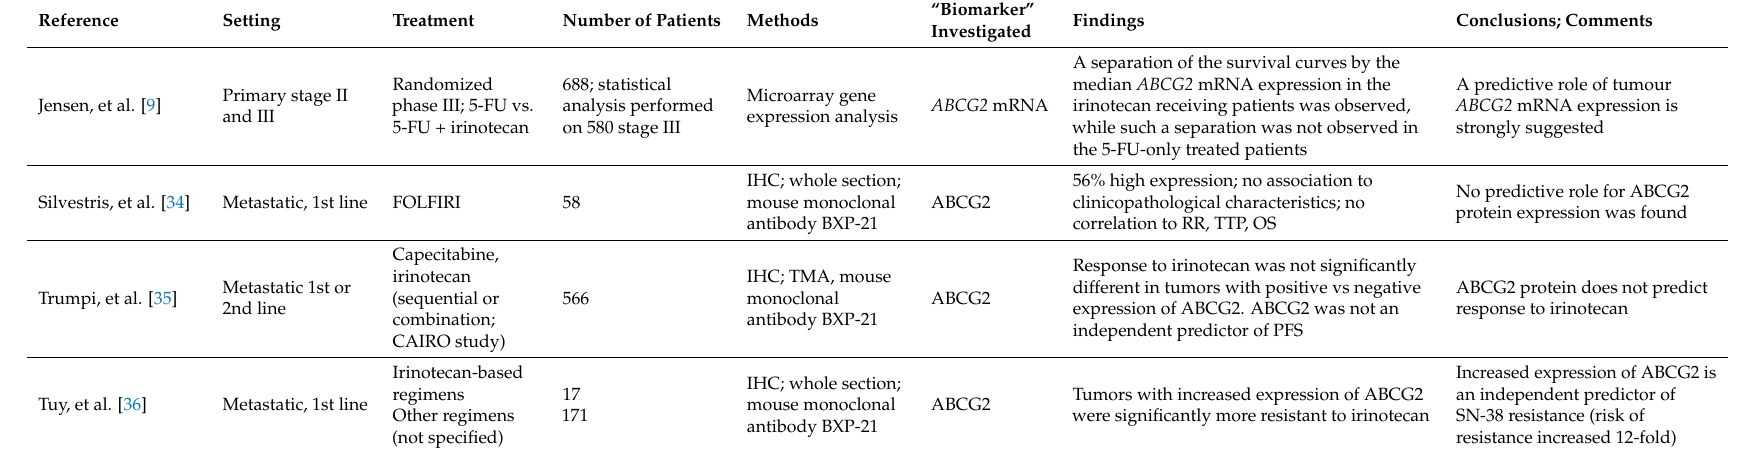
Table 2. Studies of ABCG2 gene and protein expression in CRC in relation to the prediction of outcome after irinotecan-based